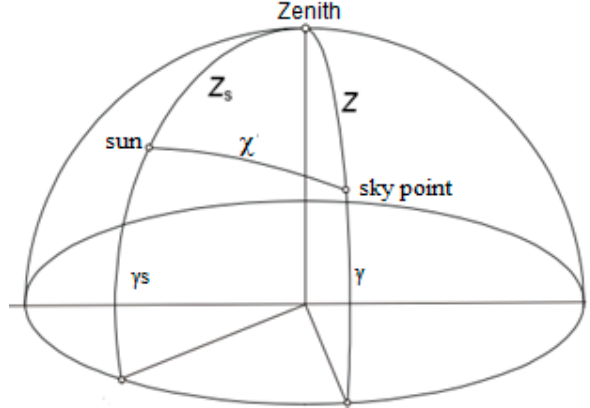
Figure 1. Angles that define the position of the sun and a sky point.